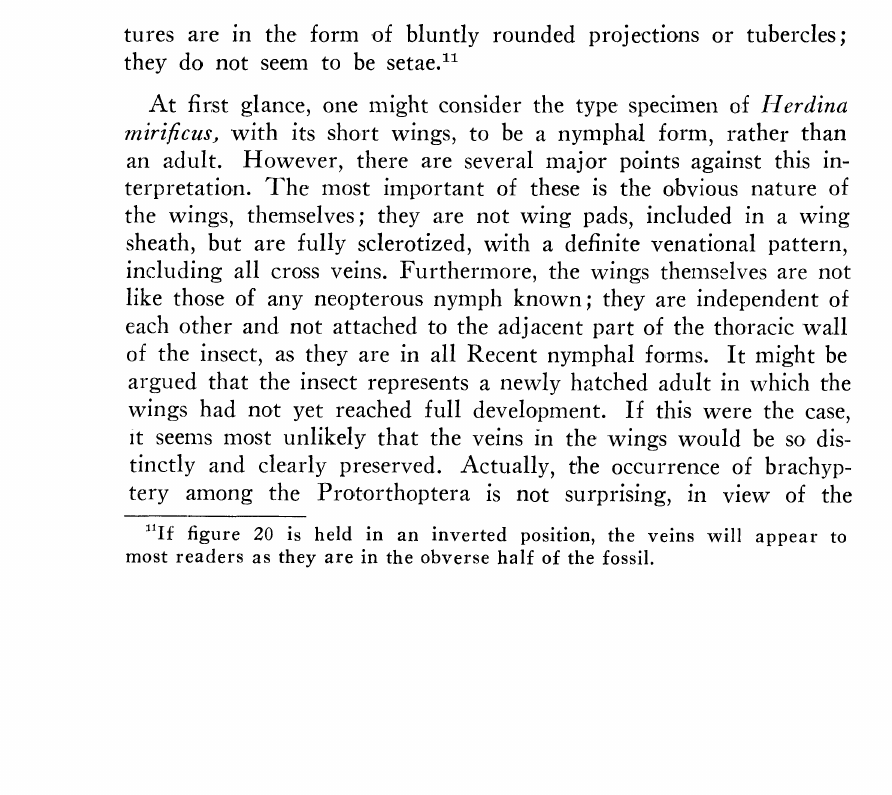
Figure 19. Herdina miri/icus, n.sp. Photograph of fore and hind wings of holotype, No. H 412a, Herdina collection (obverse). tures are in the form ,of bluntly rounded projections or